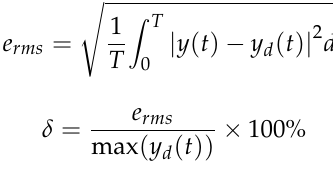
Figure 11. Time histories of: ( a ) A waveform of input excitation signal with the amplitude of 20 and ( b ) the measured and simulation results predicted by the GB–W model and CB–W model.